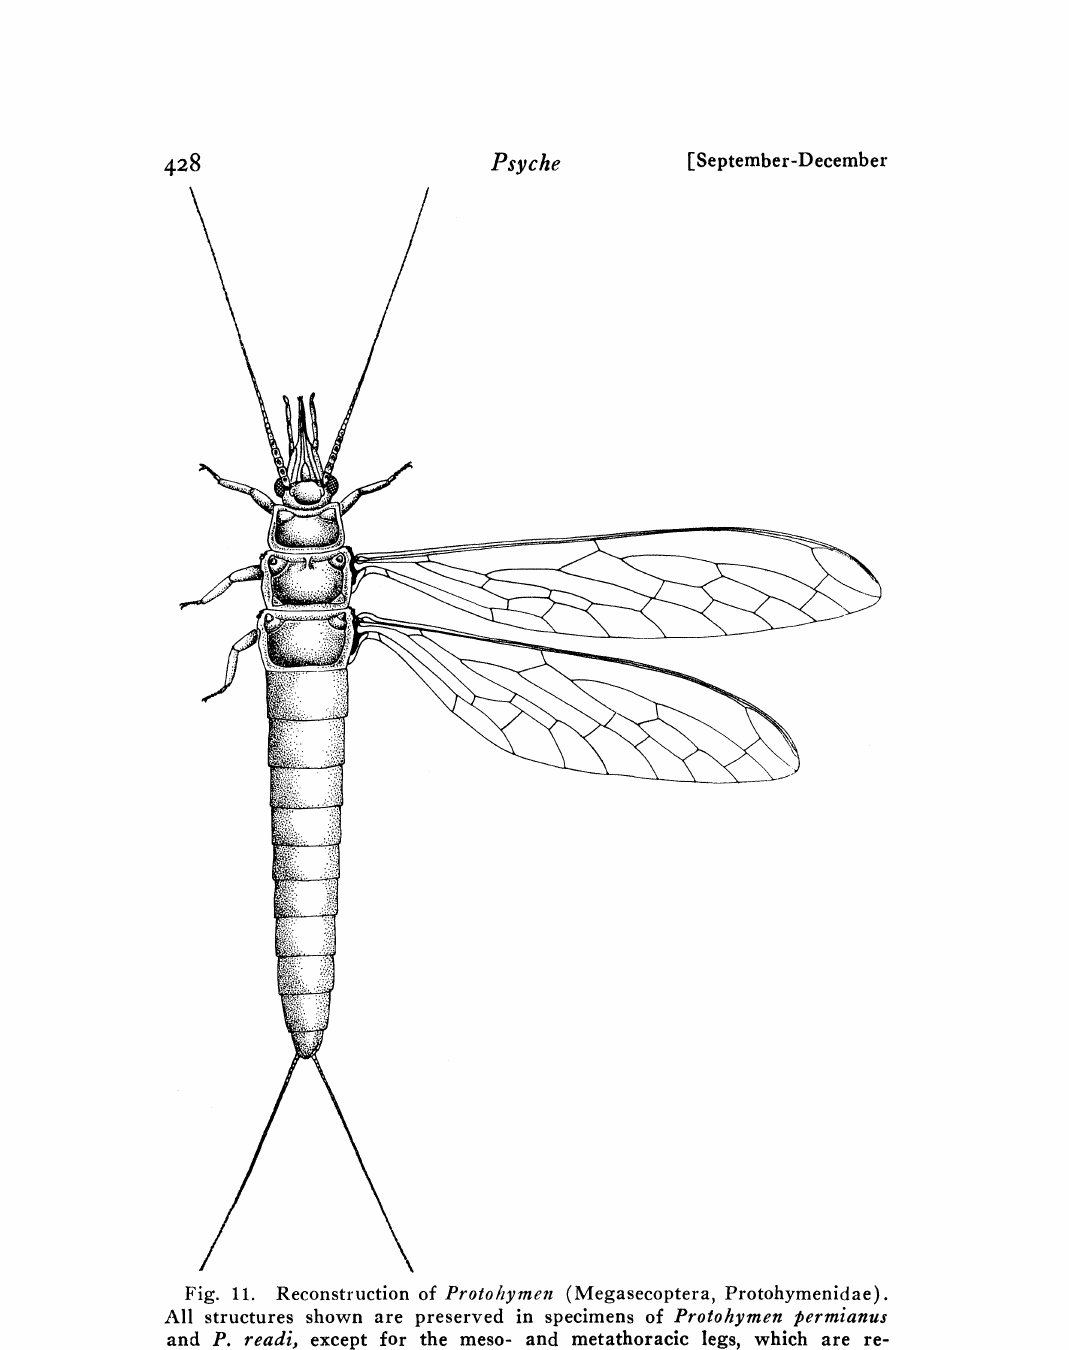
Fig. 11. Reconstruction of Protohymen (Megasecoptera, Protohymenidae). All structures shown are preserved in specimens of Protohymen ermianus anti P. readi, except for the meso- and metathoracic legs, which are re- stored on the basis o: the prothoracic legs. Original. Lower Permian,